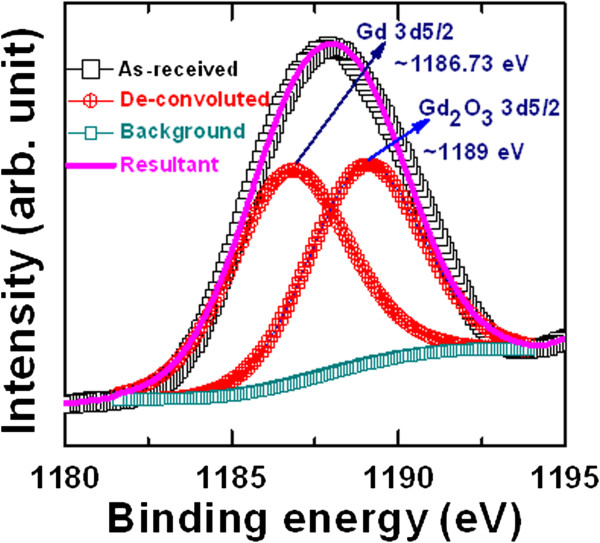
XPS characteristics of the Gd2O3 films. XPS spectra of the Gd 3d and Gd2O3 3d core-level electrons.